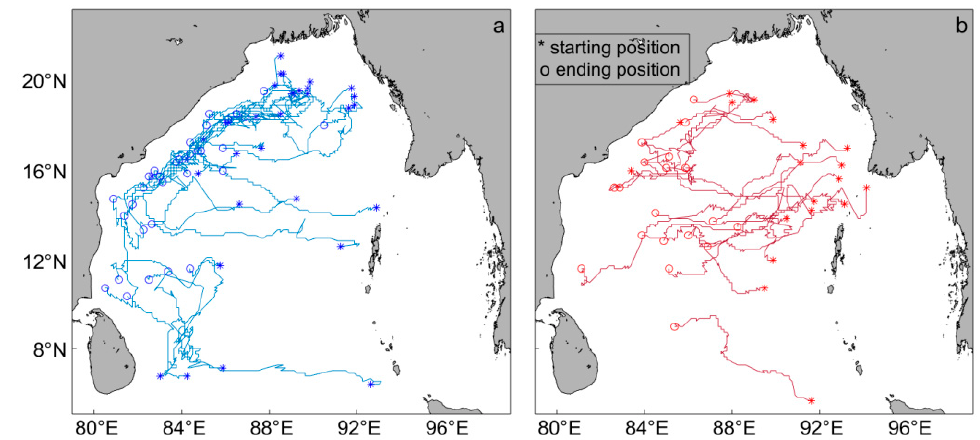
Figure 13. The propagation trajectories of the ( a ) CEs and ( b ) AEs with lifespans of greater than 18 weeks. The asterisk indicates the starting positions of an eddy track, and the circle is the ending positions.